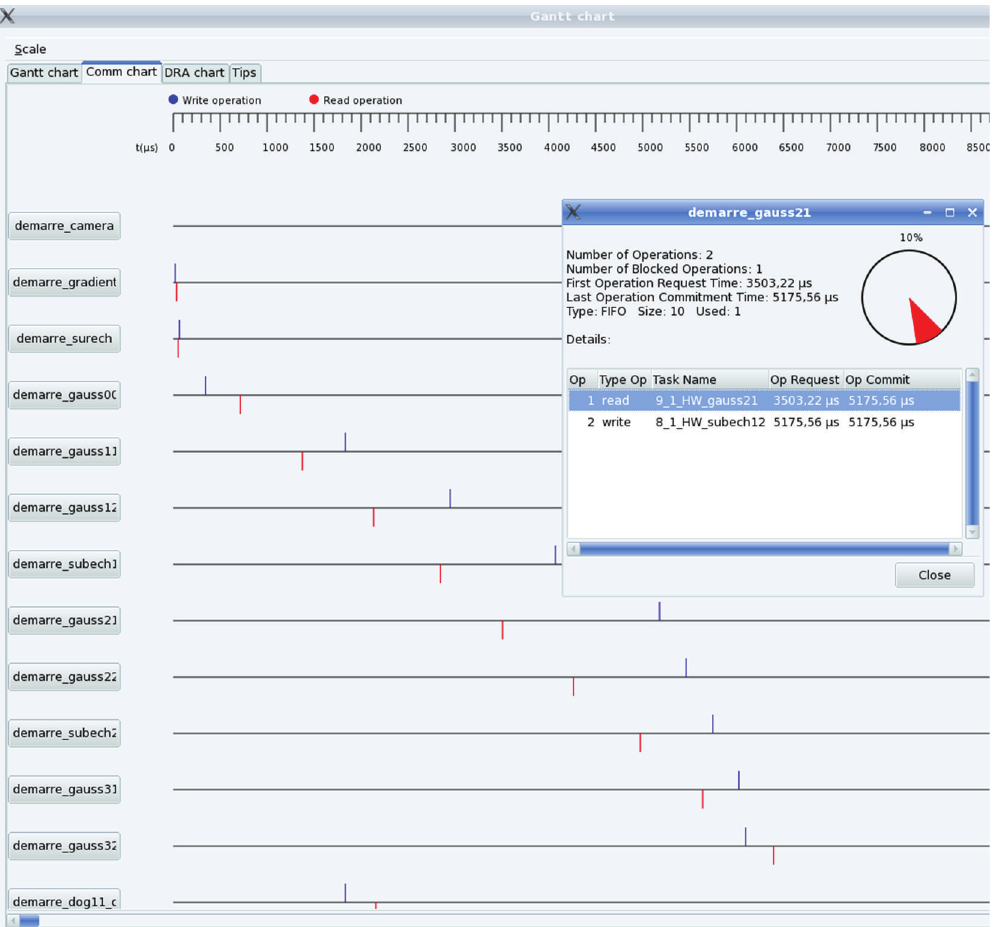
Figure 17: The DOGME tool provides several metrics helping the designer to evaluate the simulated design solutions. The window shows communications between tasks over time. It also computes the filling ratio for FIFO based